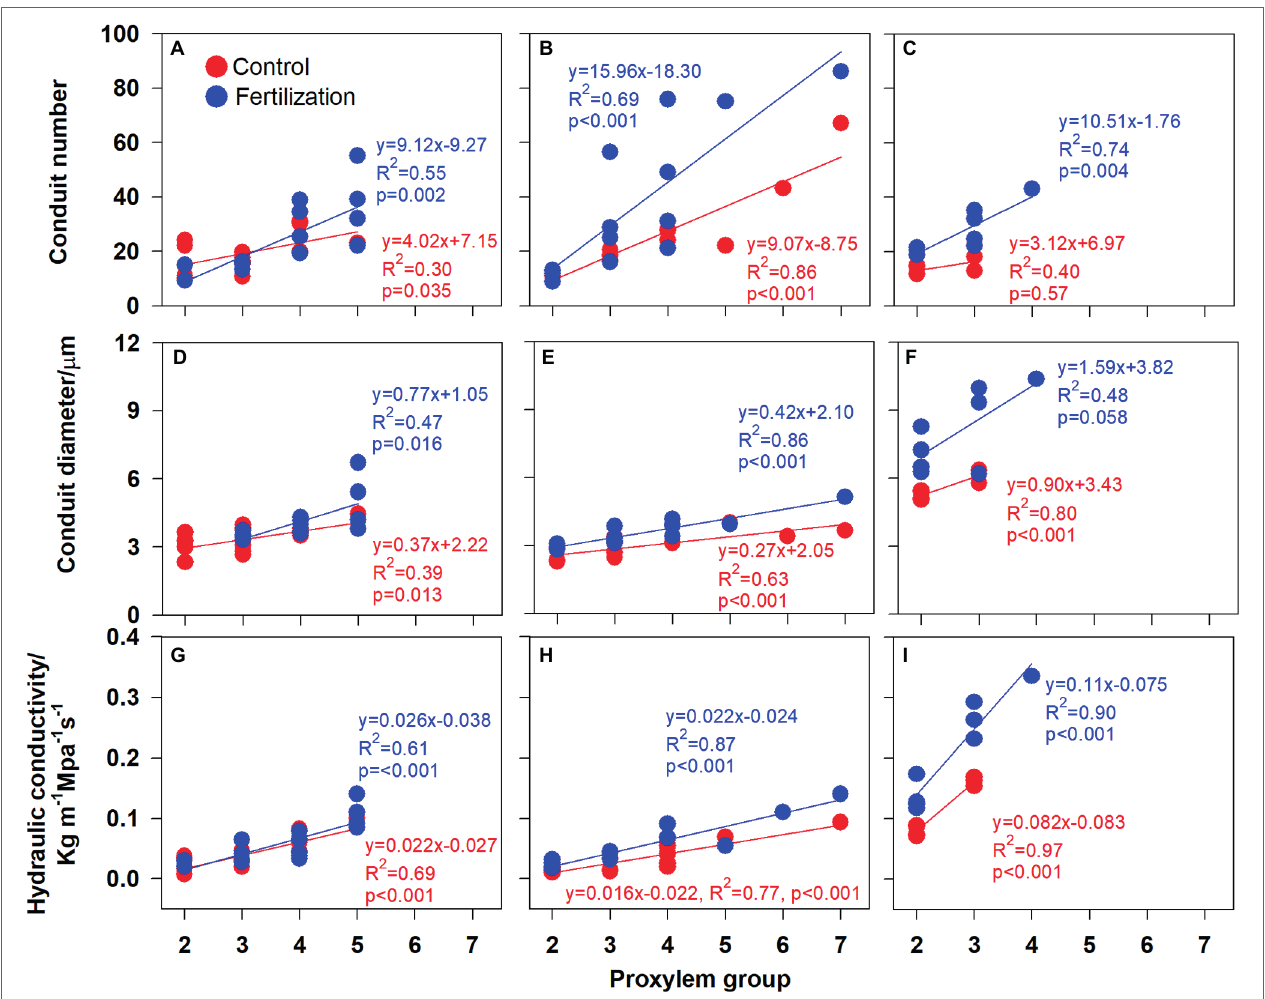
FIGURE 7 | Relationship between the root protoxylem groups number and the number and diameter of root conduit, as well as hydraulic conductivity in Juglans mandshurica (A,D,G) , Fraxinus mandshurica (B,E,H) and Phellodendron amurense (C,F,I) , respectively.